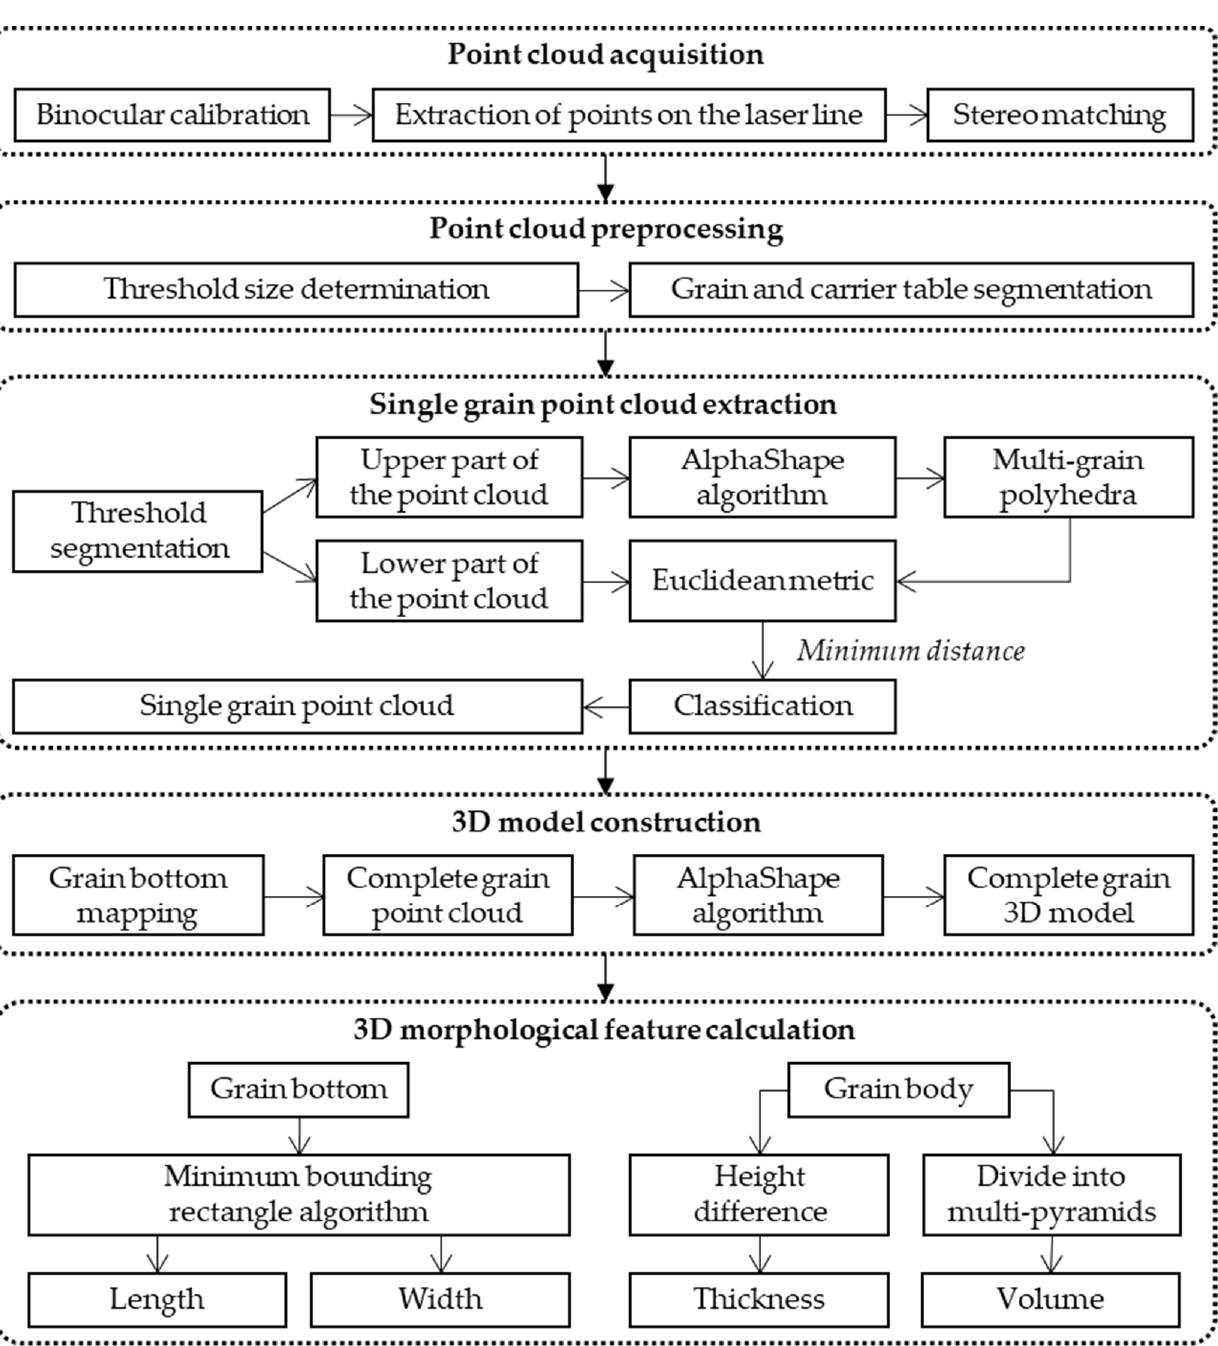
Figure 3. Grain point-cloud processing pipeline. The point P in Figure 4a is a point in 3D space; O L and O R are the left and right camera optical centers; and P L and P R are the imaging points of the point P on the left and right image planes. The parallax of the point P in the left and right cameras is defined as Disparity = | u L − u R | , (1) where u L and u R are the distances of the two imaging points on the left and right image planes from the left edge of the image,